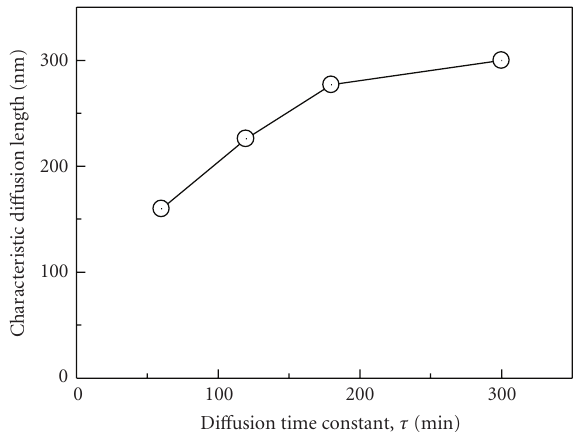
Figure 8: Variation of Characteristic di ff usion length with